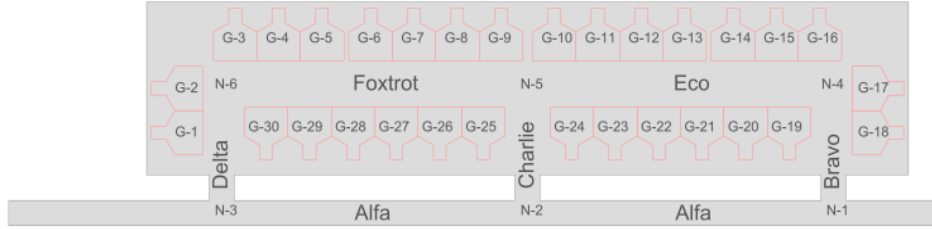
Figure 2. Parking stand assignment diagram.